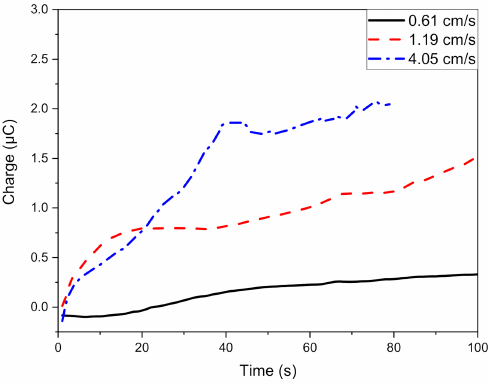
Figure 5. GF electrification curves at different scrolling velocities obtained following 1T path.